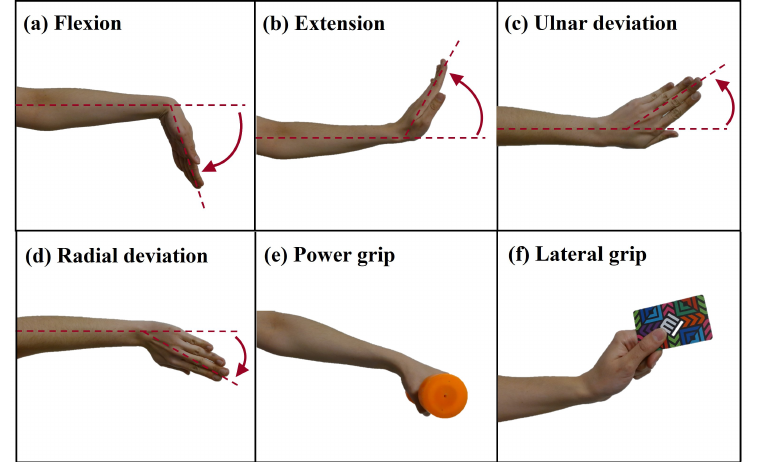
Figure 7. Movements executed in the test